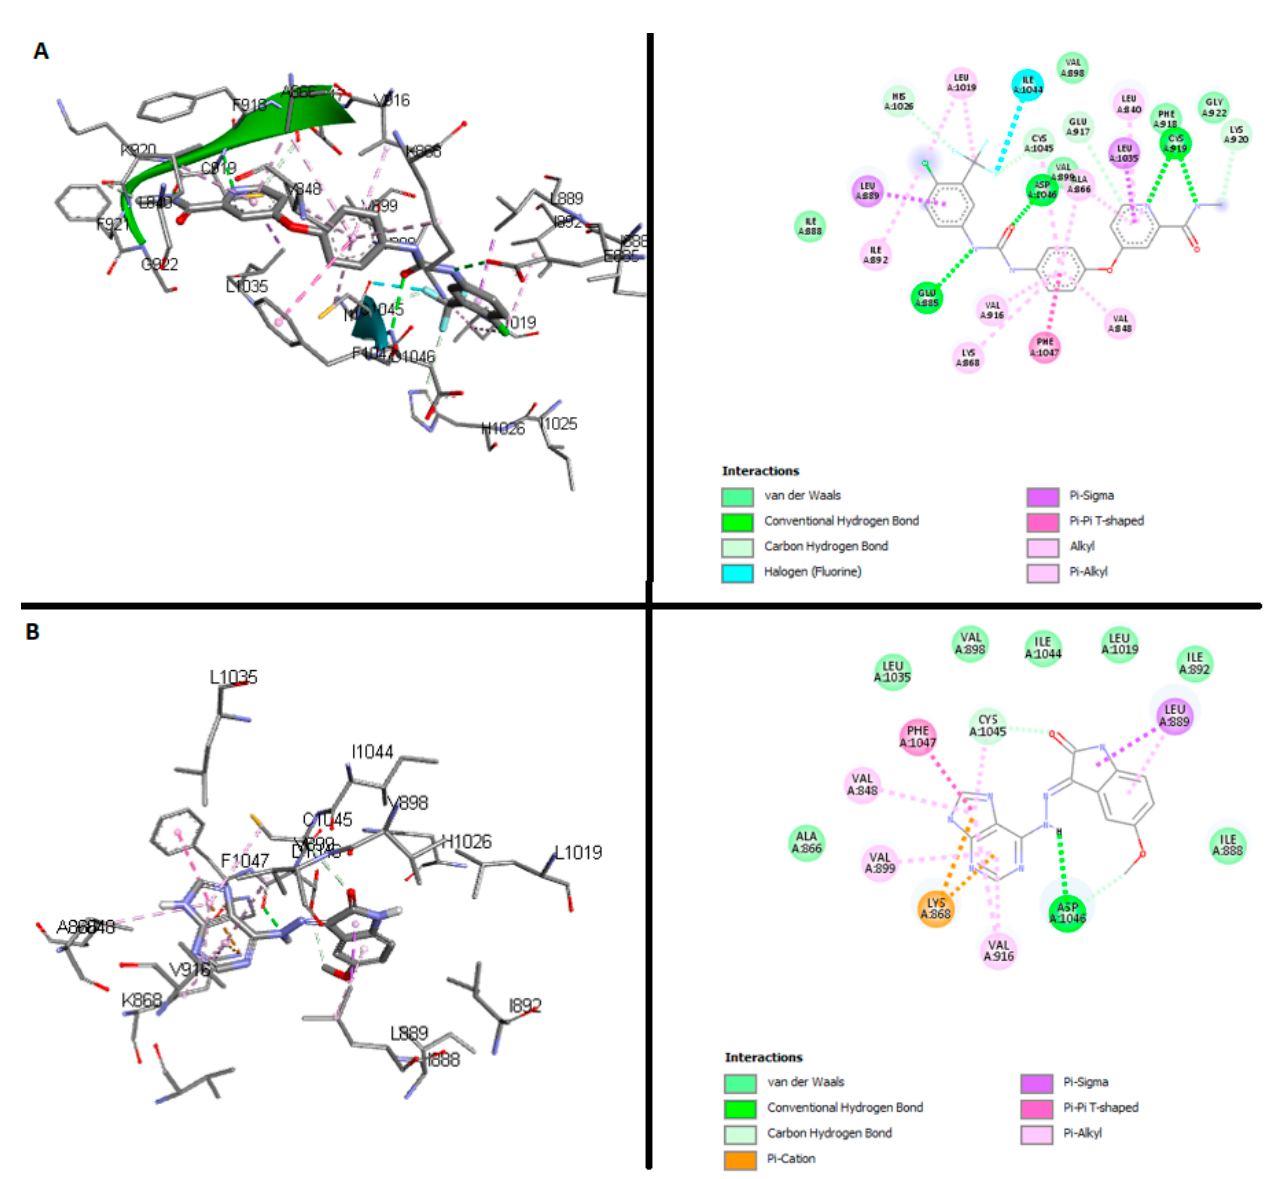
Figure 4. Schematic 2D and 3D representation of docking analysis of sorafenib ( A ) and compound 15 ( B ) in the active site of VEGFR2 (PDB ID: 4ASD).